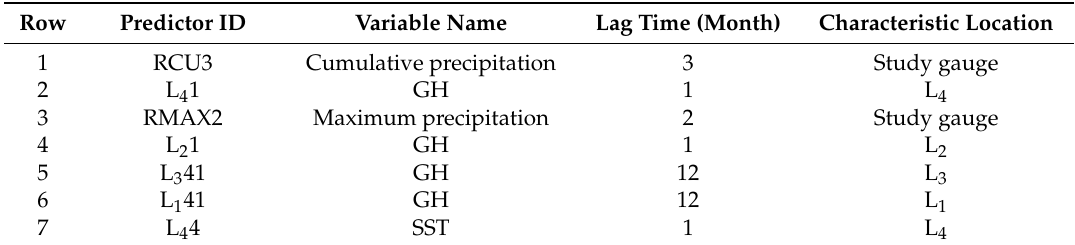
Table 7. List of the variables as criteria in TOPSIS model with the best simulation performance for forecasting RCU.